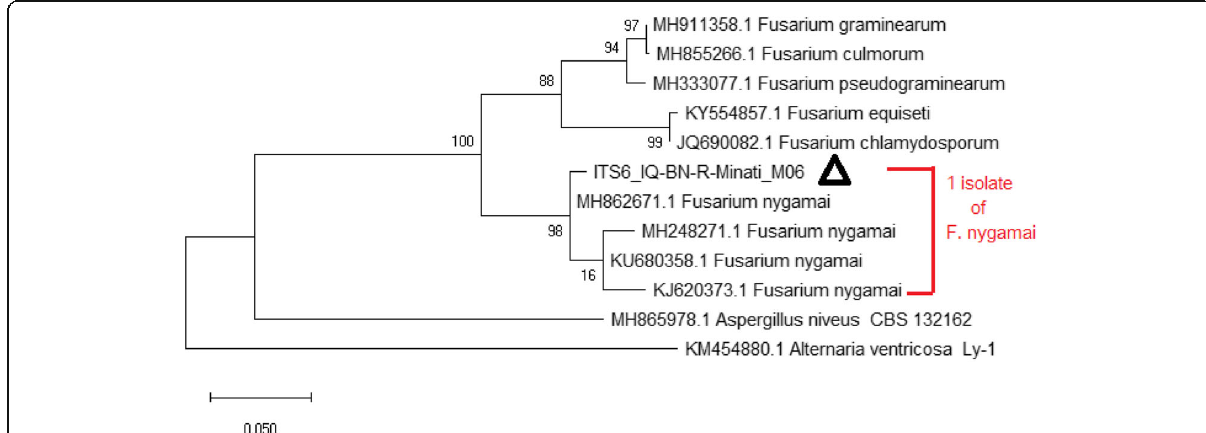
Fig. 12 Phylogenetic tree generated with the ITS-rDNA sequence of the Fusarium nygamai (1), as inferred from the maximum likelihood (ML) analyses (determined by black triangles) and related species retrieved from GenBank. ITS sequences of Aspergillus niveus (MH865978) and Alternaria ventricosa (KM454880) were used as the out-group species